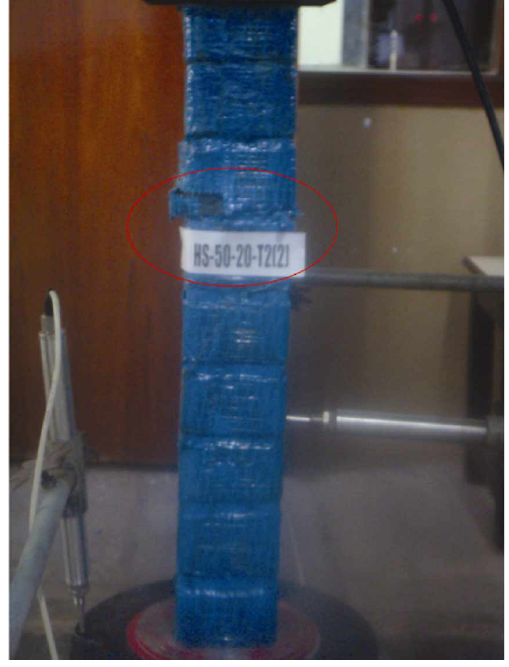
Fig. 5. Failure mode of column HS-50-20-T2(2)